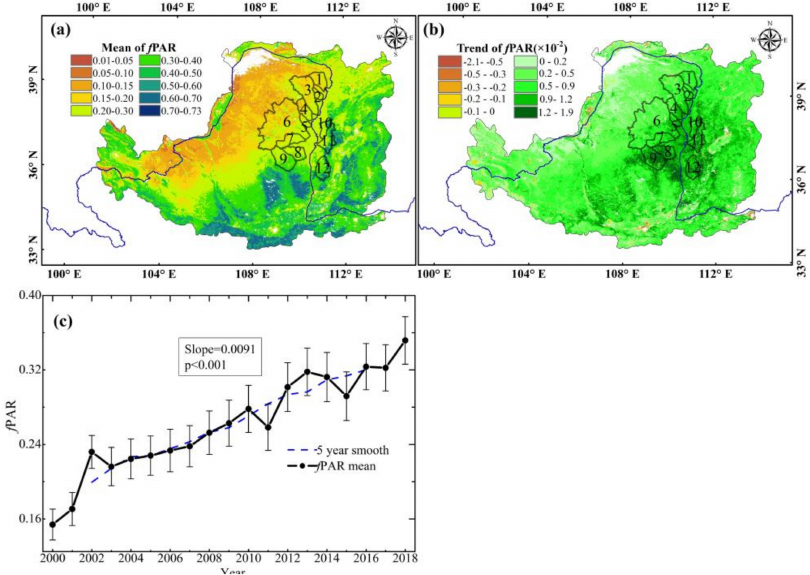
Figure 5. Spatial distribution of the ( a ) mean, ( b ) f PAR trend, and ( c ) annual variation estimated from 500 m MODIS vegetation index in the Loess Plateau from 2000 to